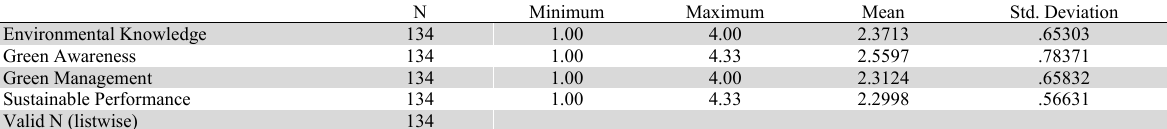
Value of Mean, Variance, and Standard deviation